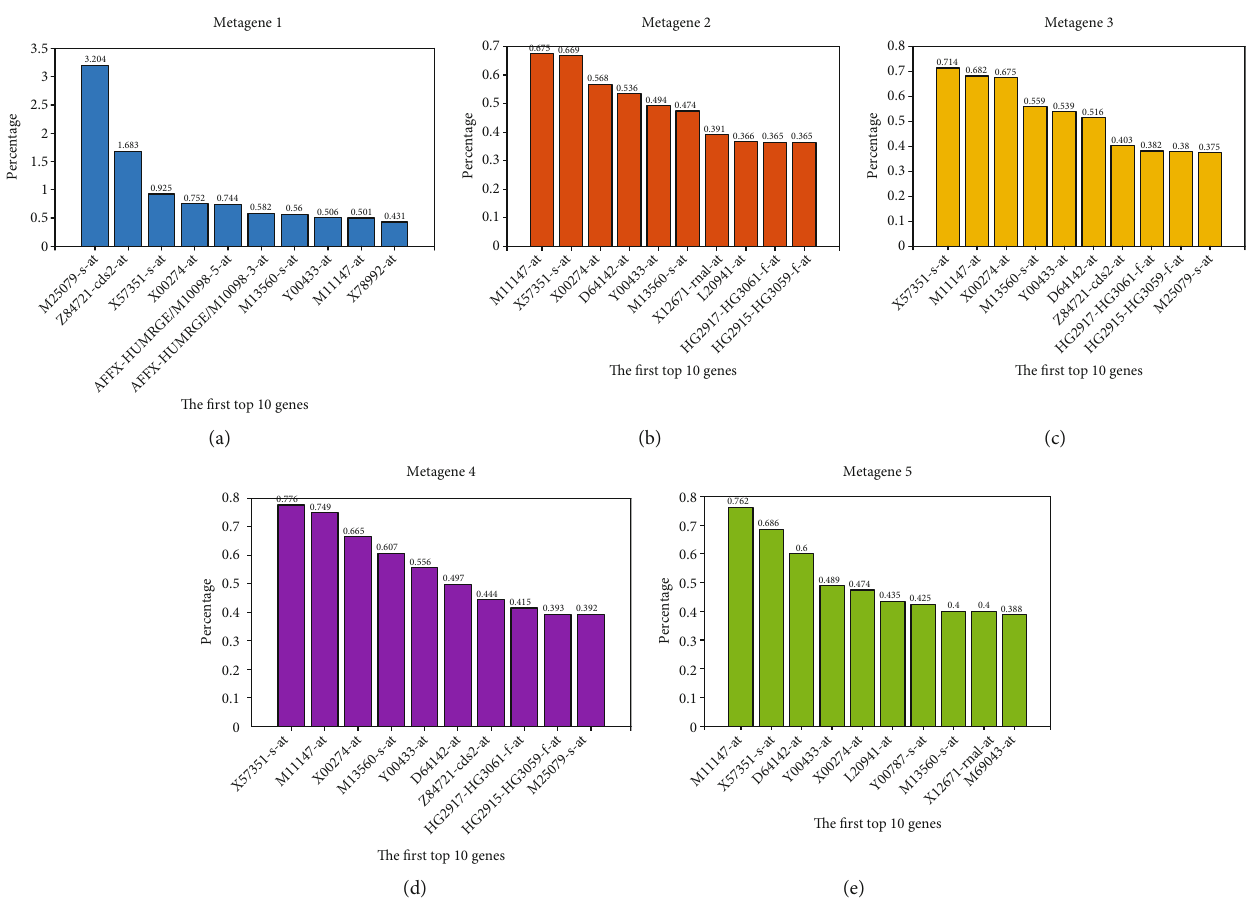
Figure 6: Composition of the fi ve metagenes (provided by CDSNMF) of ALL-AML based on the fi rst top 10 dominant original